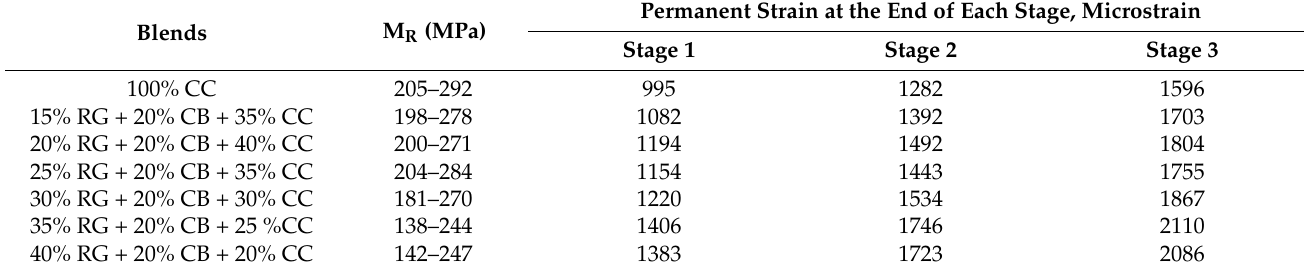
Table 3. Resilient modulus and permanent strain testing for the nominated